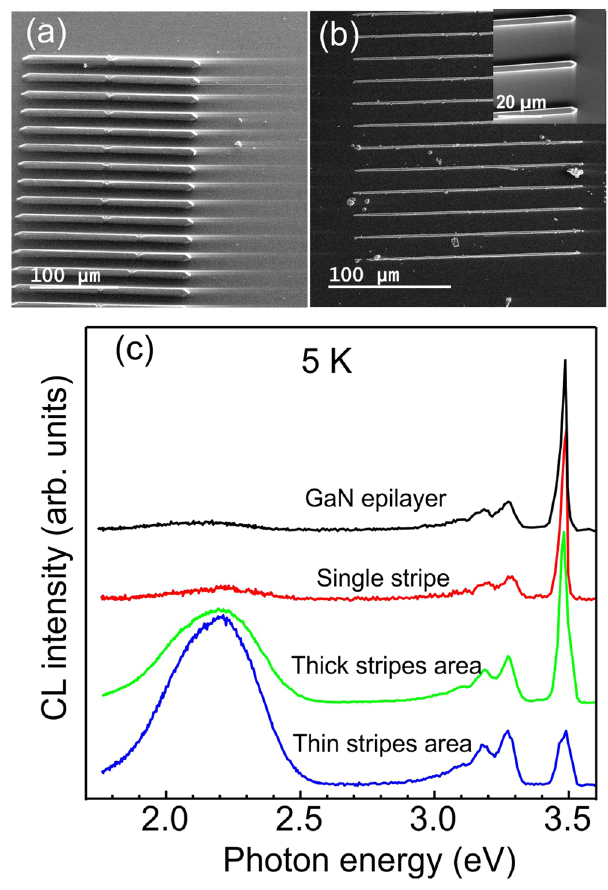
Figure 3. SEM image of the patterned area with GaN planar nanowires with width of 6 µ m ( a ) and 2 µ m ( b ). The enlarged image of thinner planar stripes is depicted as the inset. ( c ) Low-temperature CL spectra taken from average patterned area (a) and (b) are shown by green and blue lines, respectively. Emission spectrum shown by the red line is measured for a single stripe, i.e. when the electron beam is in the focused mode. CL spectrum measured for the bare epitaxial GaN layer is shown by a black line. Spectra are normalized and shifted vertically for